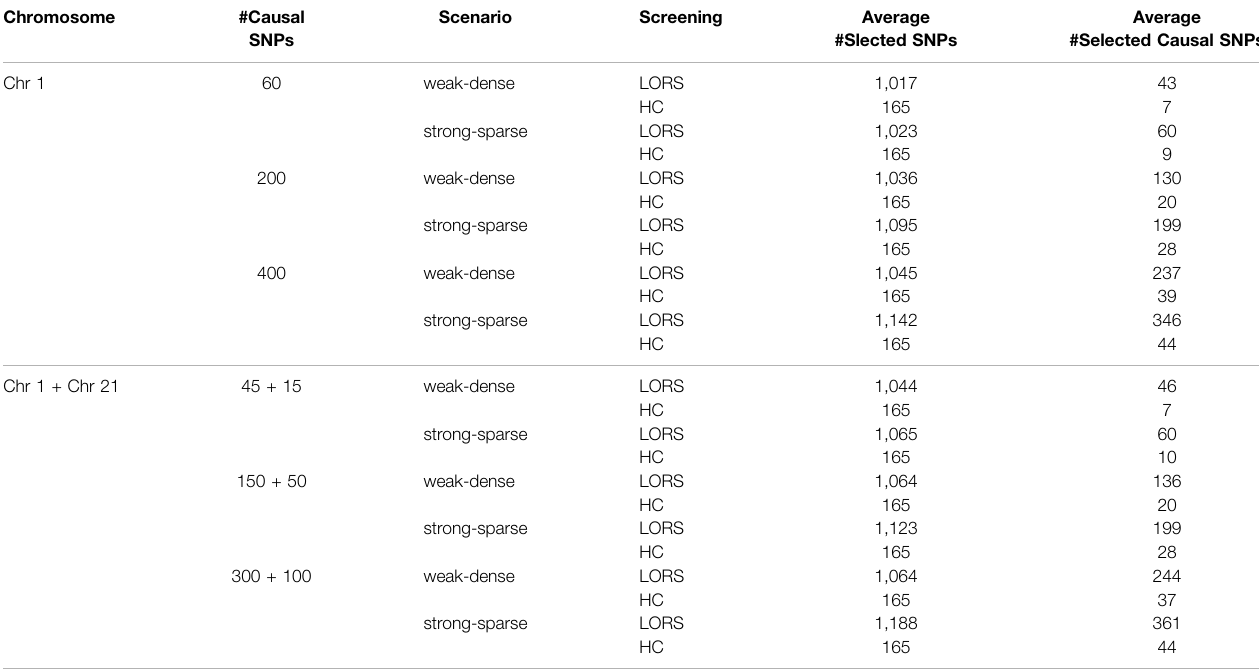
TABLE 2 | Results of the HC-Screening and the LORS-Screening with ten replicates for each simulation scenario.